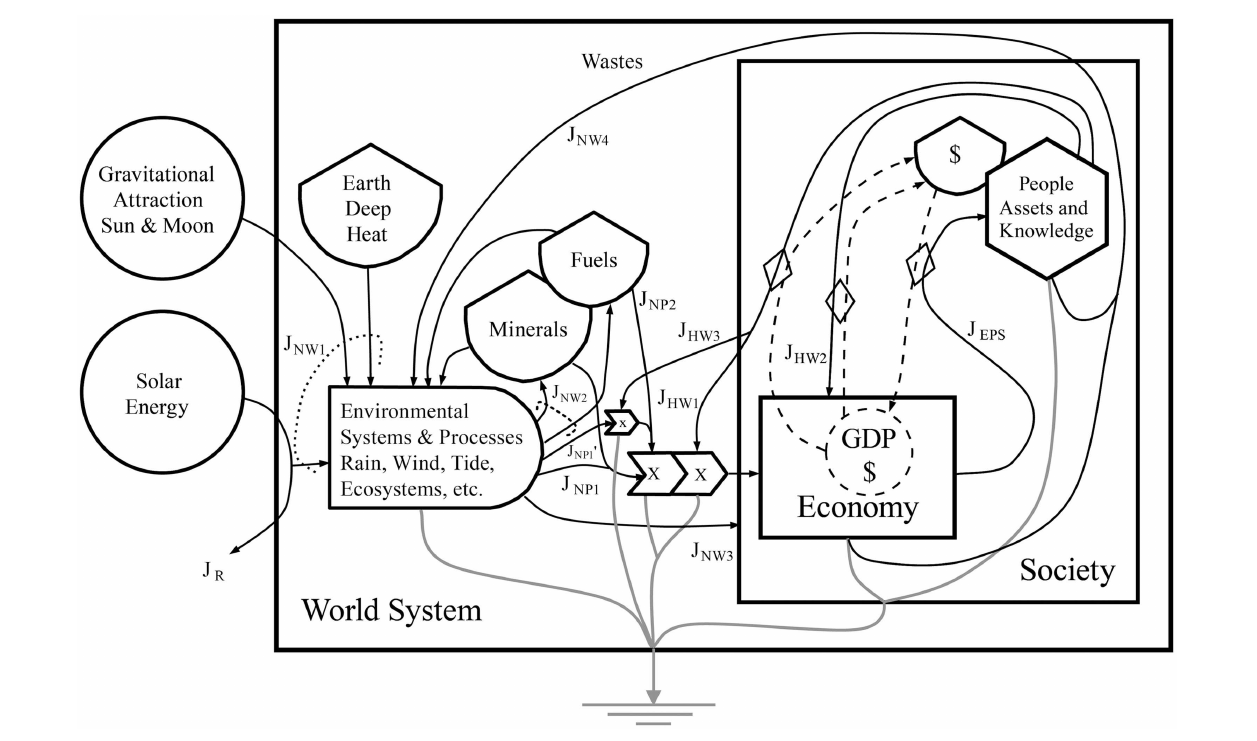
lines), and money (dashed lines). System boundaries and subsystems are delineated by boxes, the interaction of flows by rectangular arrows containing a mathematical symbol, production systems by the bullet shaped symbol, and consumers by the hexagon.The exchange of money for goods is represented with a diamond symbol (Odum,